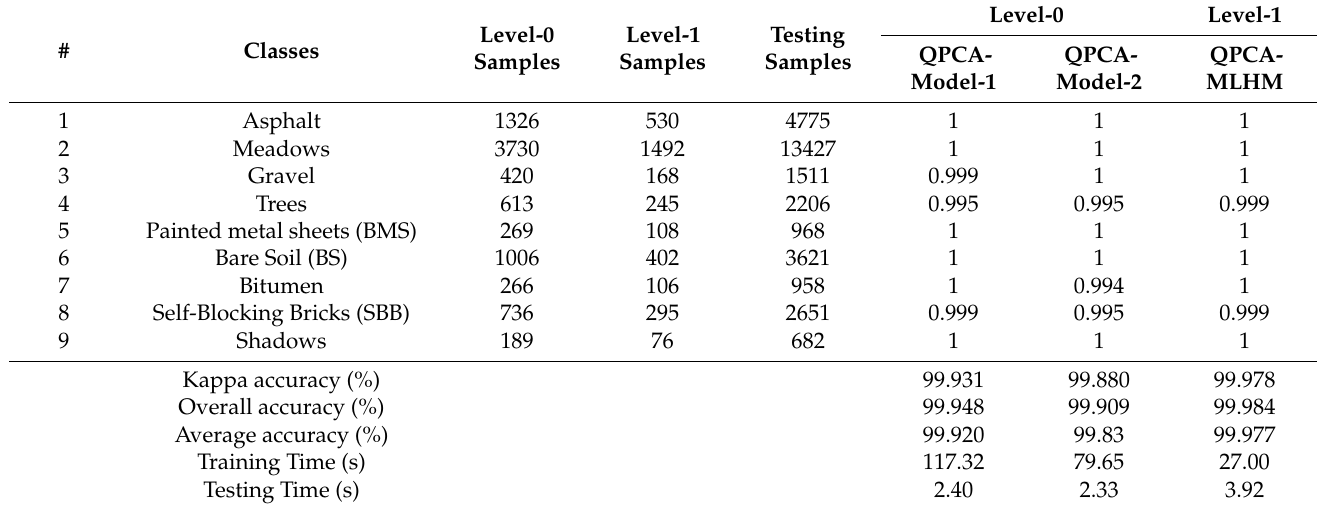
Table 4. The sample number of level-0 and level-1 datasets. It also indicates the results of the